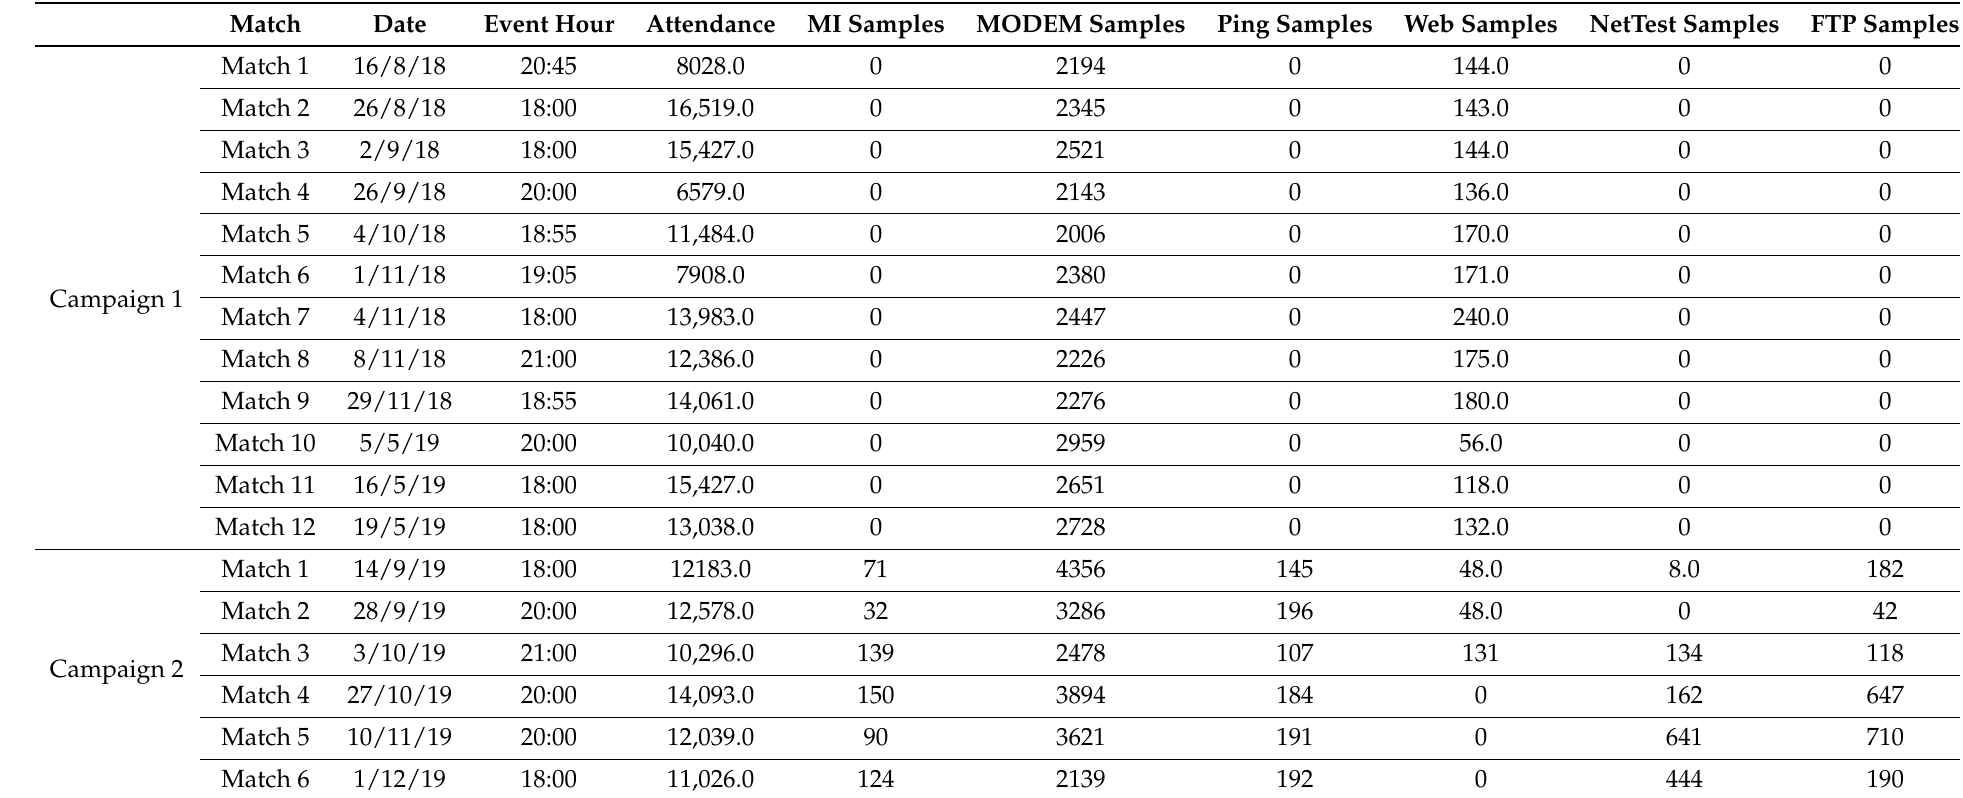
Table 3. Descriptions of measurement